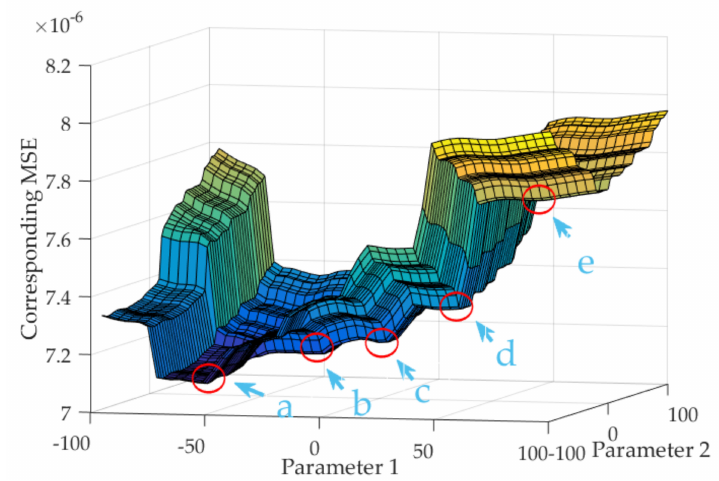
Figure 7. The local optimums of BPNN in some